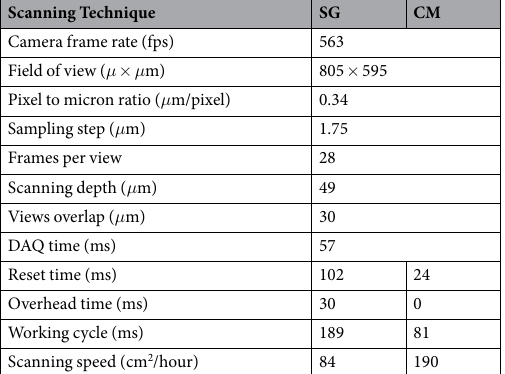
Table 1. Comparison of LASSO scanning parameters and performances between the SG and the CM